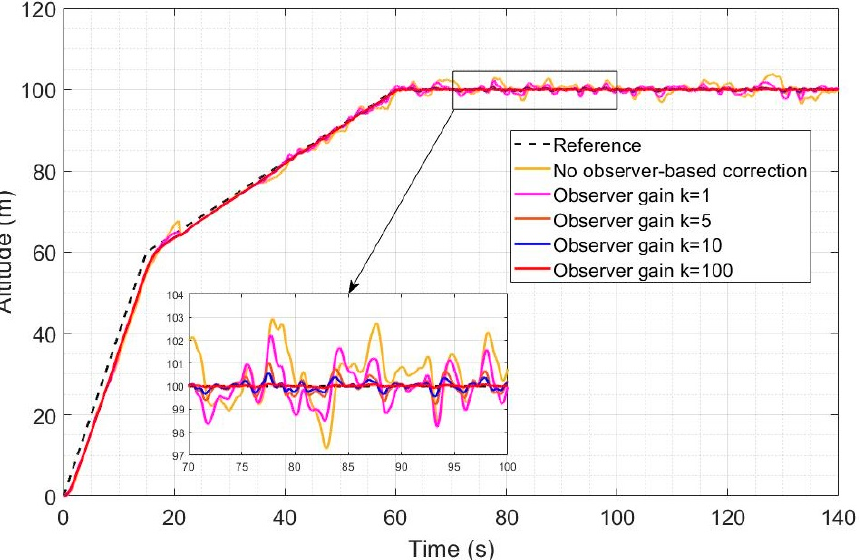
Figure 6. Altitude reference tracking under a high wind intensity for different values of the pertur- bation observer gain.